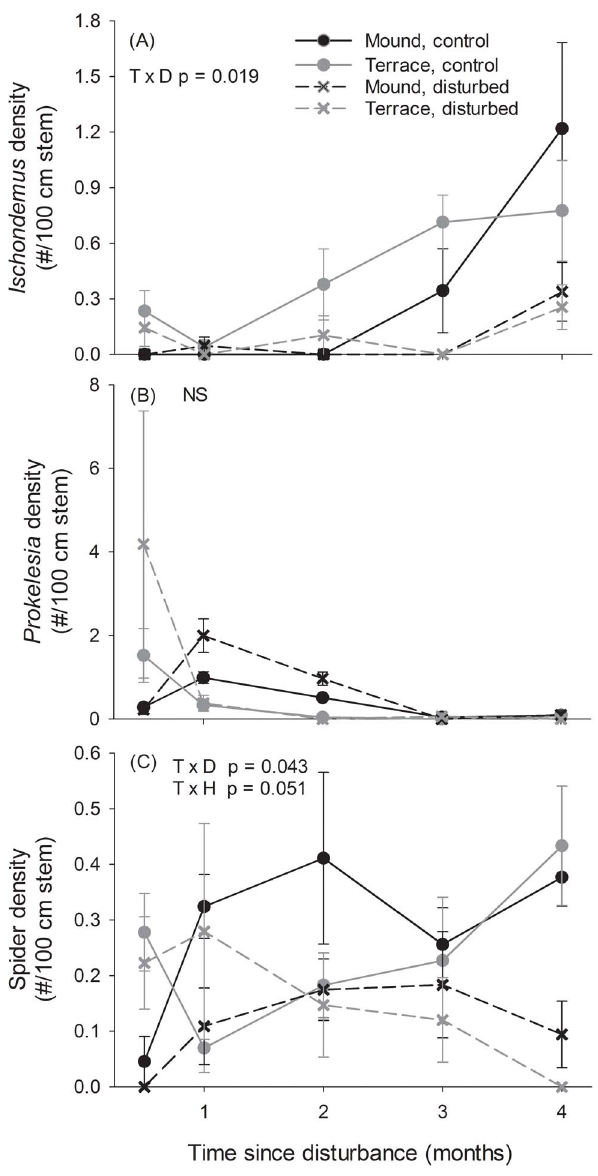
Figure 3. Disturbance and patch size effects on arthropod characteristics. Effects of disturbance treatments in large (terraces) and small (mounds) patches over time on arthropod characteristics: a) Ischnodemus density, b) Prokelesia density, c) spider density. Error bars represent standard error. Significant treatment effects from two-way repeated measures ANOVA are noted; T=time, D=Disturbance, H=Habitat patch size, NS=no significant treatment effects.